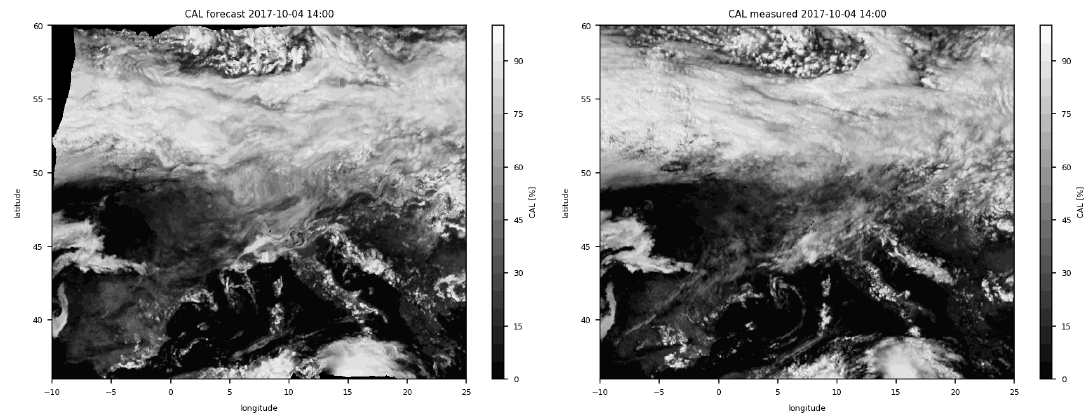
Figure 6. A short-term forecast for 120 min of the effective cloud albedo for 4 October 2017 at 14:00 UTC can be seen in the left figure. The satellite image by MSG with the effective cloud albedo depicted for comparison is shown in the right image.